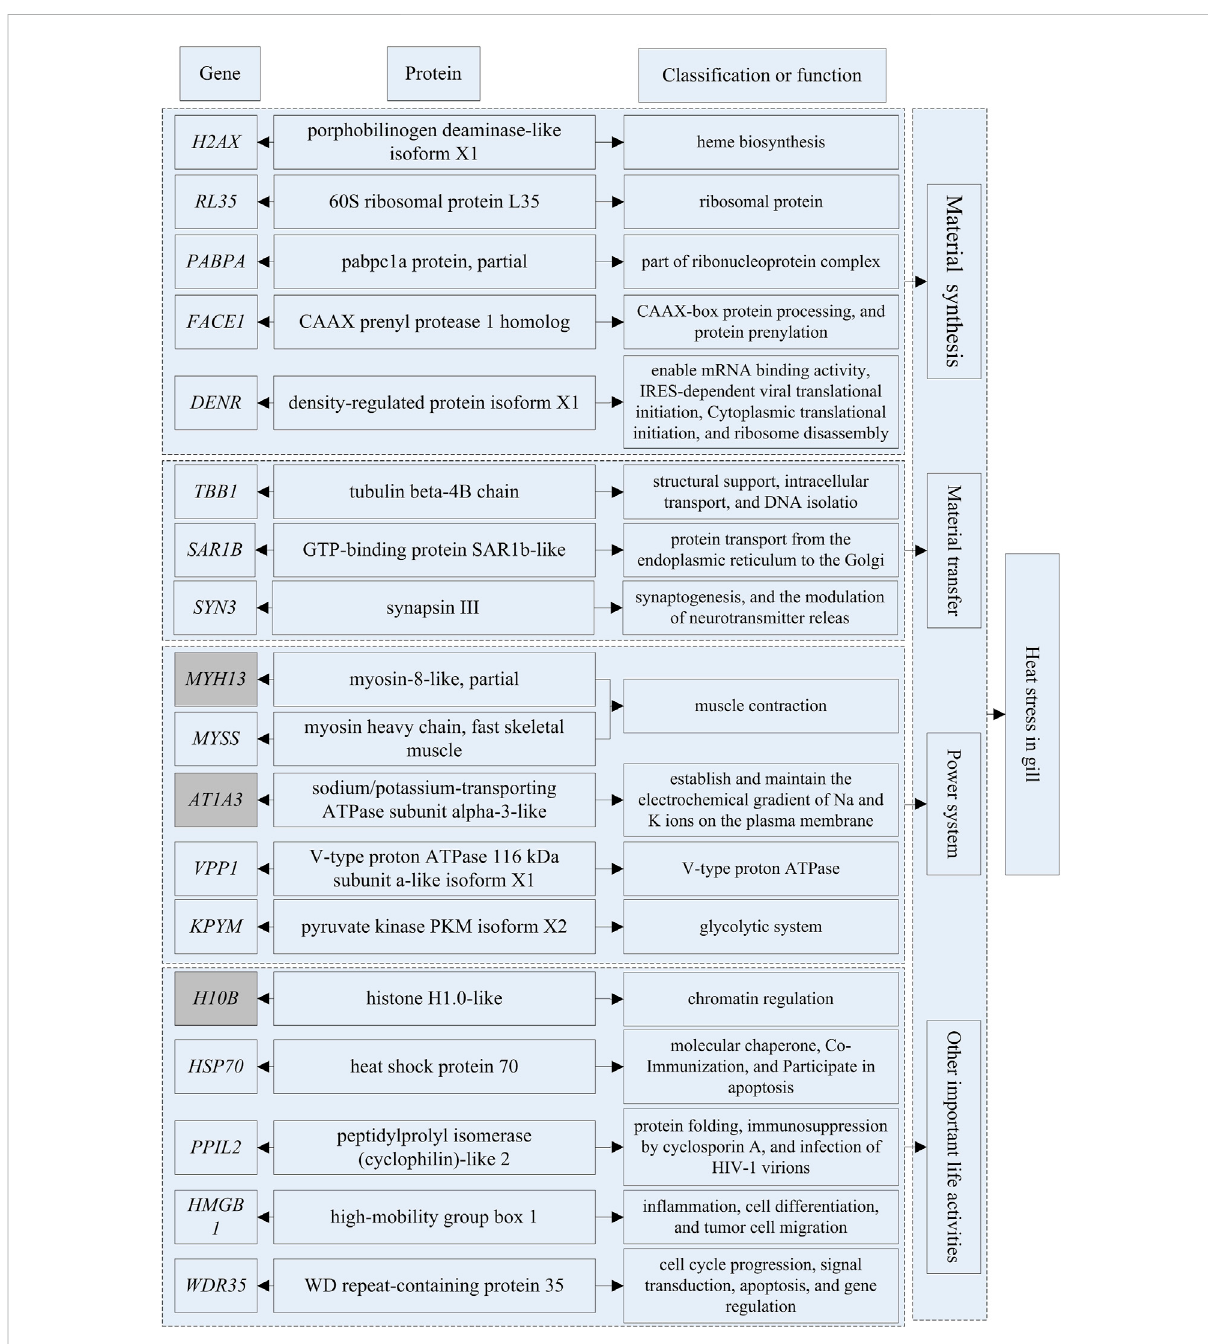
FIGURE 7 The diagram of gene-protein-potential functions in